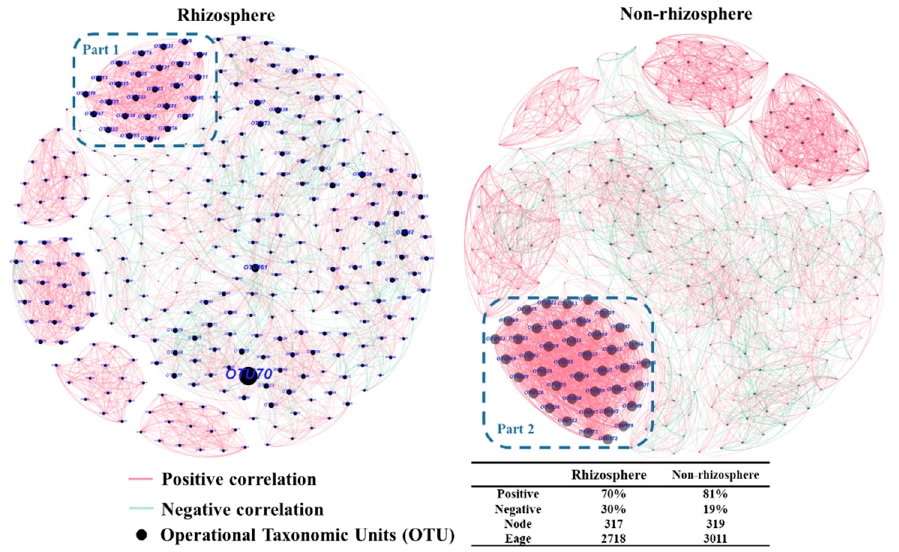
Figure 3. Co-occurrence network of the differential operational taxonomic units in soils.